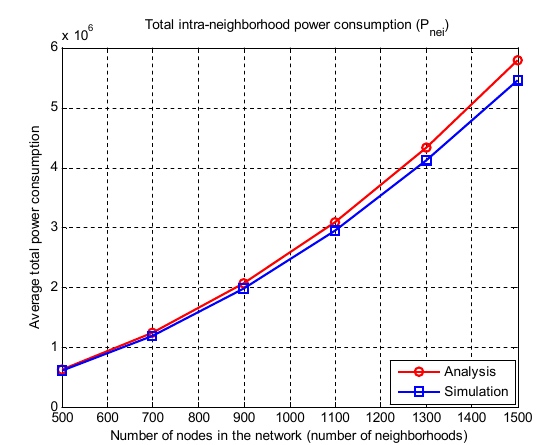
Figure 13. Total intra-neighborhood power consumption with different number of sensors deployed in a circular sensing area